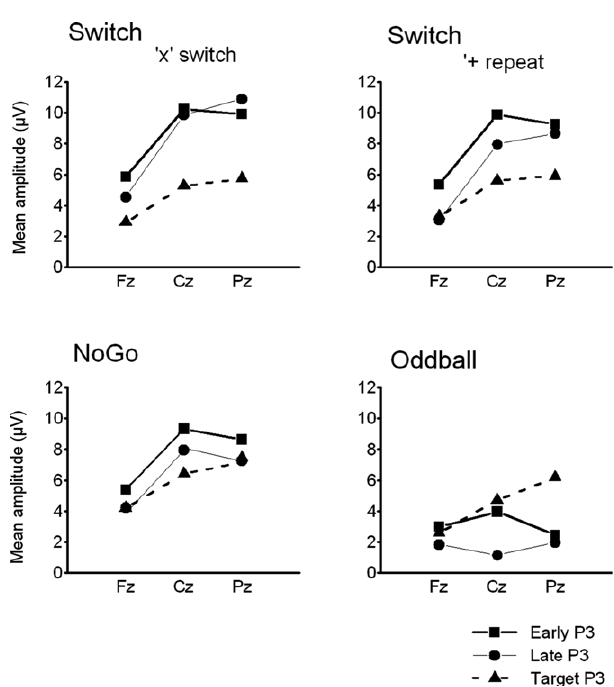
Figure 5. Summary of grand mean amplitudes from 3 midline electrodes (Fz, Cz, Pz) of early and late cue-locked P3 and target-locked P3 acti- vations in the 3 task conditions: Switch (comparing ‘ x ’ switch and ‘ + ’ repeat trials), NoGo and Oddball tasks (with ‘ x ’ and ‘ + ’ trials collapsed). Note the distinct scalp distribution of cue-locked P3 – but not of target-locked P3 – activity across the 3 task